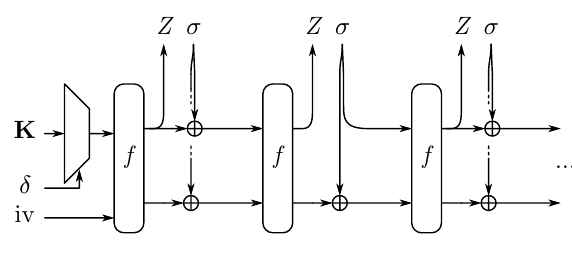
Figure 1: The full-state keyed duplex